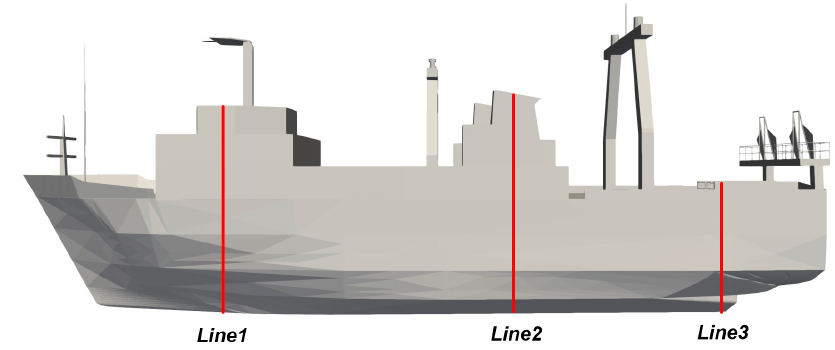
Figure 3. Location of the wave pressure gauge on the artificial vessel reef model.